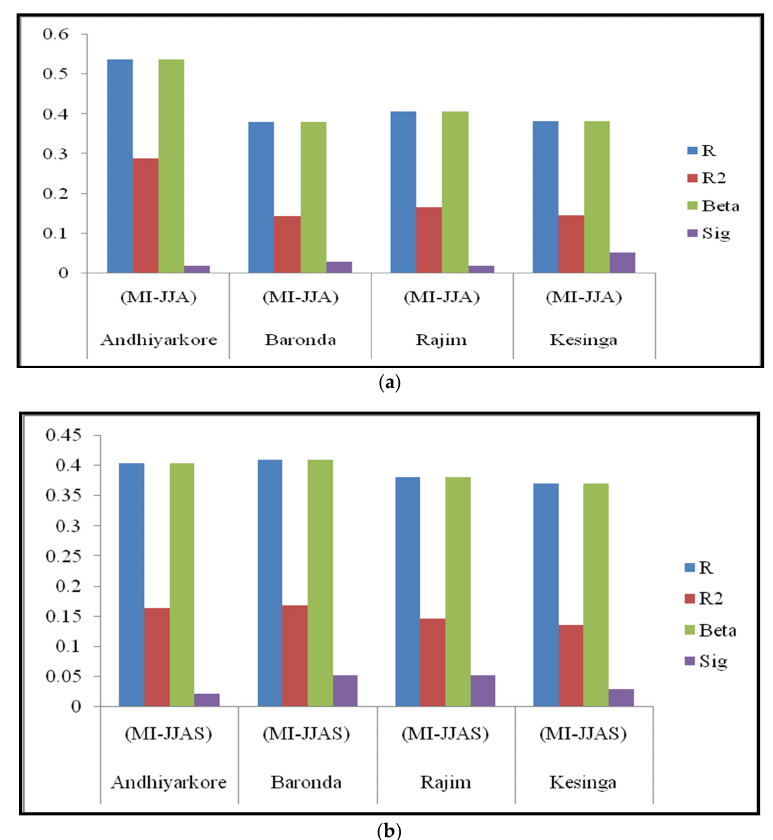
Figure 5. ( a ) Stepwise regression analysis for JJA season, taking MI-JJA, MI-JJAS, and MI-JAS as the independent variables; ( b ) Stepwise regression analysis for SON season taking MI-JJA, MI-JJAS, and MI-JAS as the independent variables.